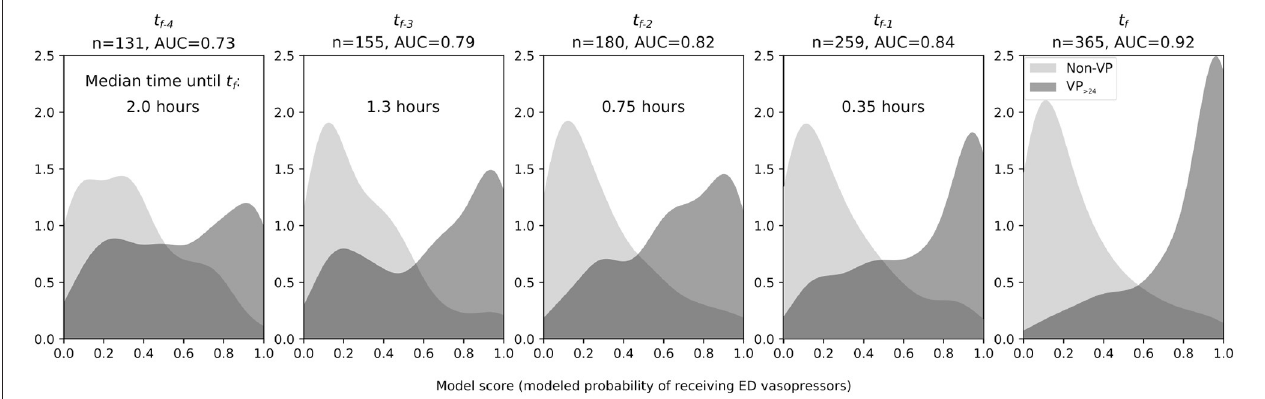
FIGURE 3 | Smoothed observed density functions for scores from an LR model trained to discriminate between the VP > 24 group (hypotensive, septic patients requiring vasopressor infusions for > 24 h, dark gray) and the Non-VP group (hypotensive, septic patients not receiving vasopressors for at least 48 h, light gray). Time is referenced from the “final ED decision point” ( t f ), either just before vasopressors were initiated or just before ED hypotension resolved. From left to right: distributions at four vital signs observations (median 2.0, IQR 1.2–2.7 h) prior to t f , at three observations (median 1.3, IQR 0.81–2.1 h) prior to t f , at two observations (median 0.75, IQR 0.46–1.3 h) prior to t f , at one observation (median 0.35, IQR 0.18–0.68 h) prior t f , and at t f . The progressive separation of the two curves and increasing AUC show that discriminative ability increases in the approach to t f . However, a clear subset of ED vasopressor patients has model scores as early as t f − 4 and t f − 3 that exceed nearly all the scores of the Non-VP group. AUC, area under the receiver operating characteristic curve; ED, emergency department; n , total number of patient encounters included.